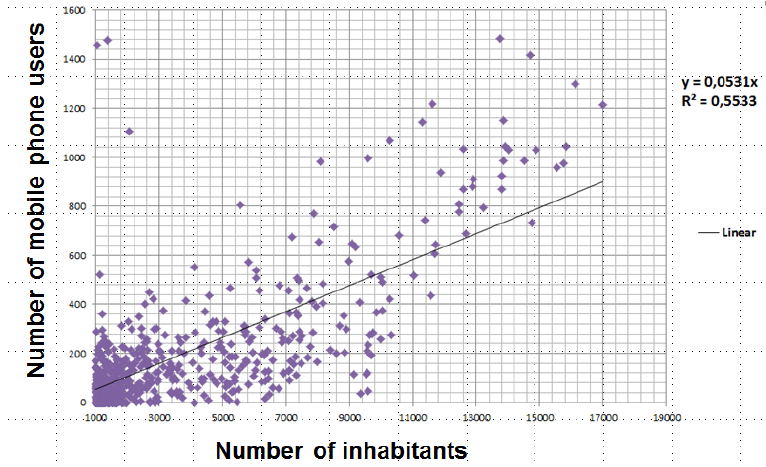
Figure 7. Statistical comparison between 1 km 2 statistical population of Vienna vs. 1 km 2 mobile phone user densities between 0:00 and 6:00 ( R 2 = 0.5533).